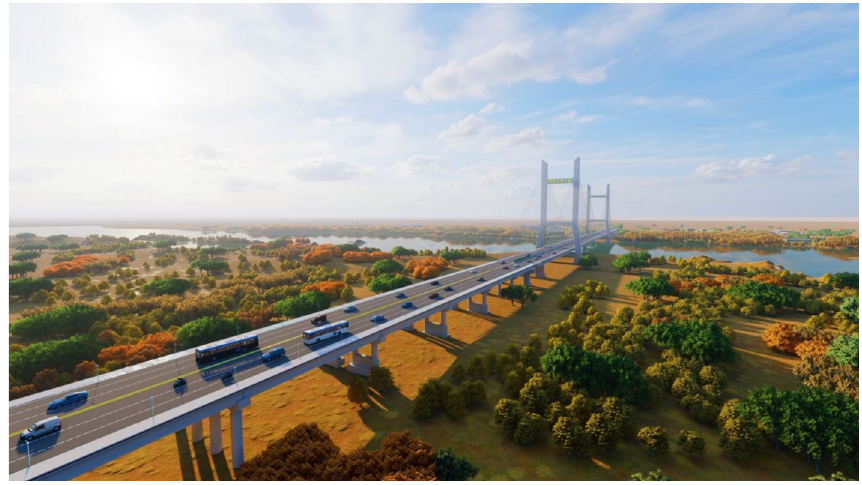
Figure 11. Rendering effect of the Cocodala Bridge BIM model.